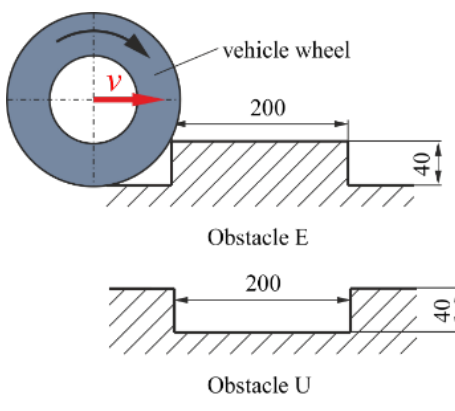
Figure 10. Obstacles types applied in simulations.